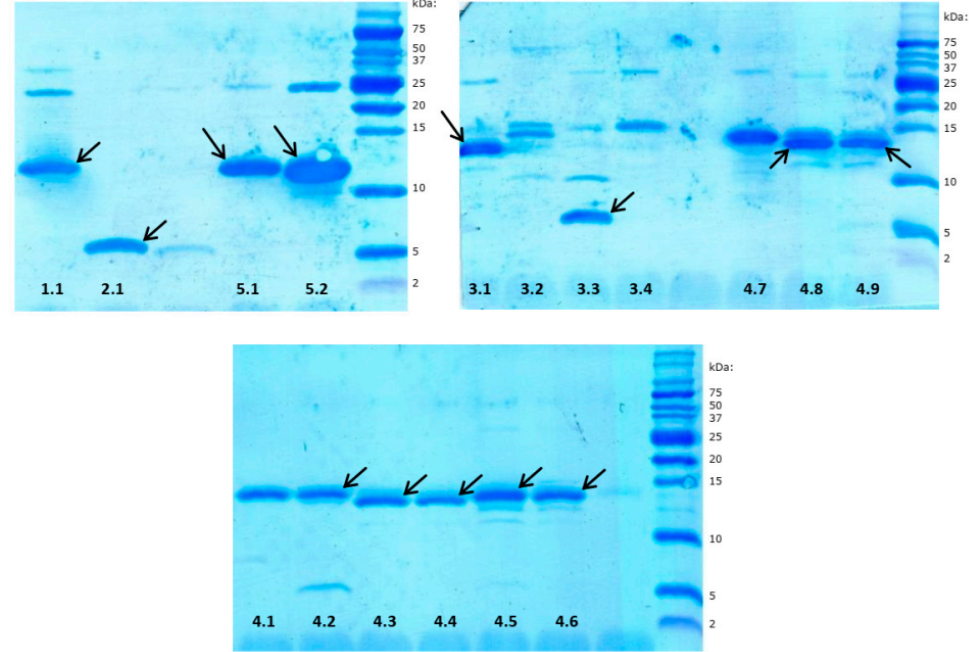
Figure 2. Sodium dodecyl sulphate polyacrylamide gel electrophoresis (SDS-PAGE) image of immune peptides and proteins isolated from Rhynchophorus ferrugineus hemolymph. The numbers correspond to the subfractions shown in Figure 1C–G. Selected bands denoted by arrows were identified by N- terminal amino acid sequencing after excision from the polyvinylidene difluoride (PVDF) membrane. The other proteins from subfractions 3.2, 4.1, and 4.7 were identified by mass